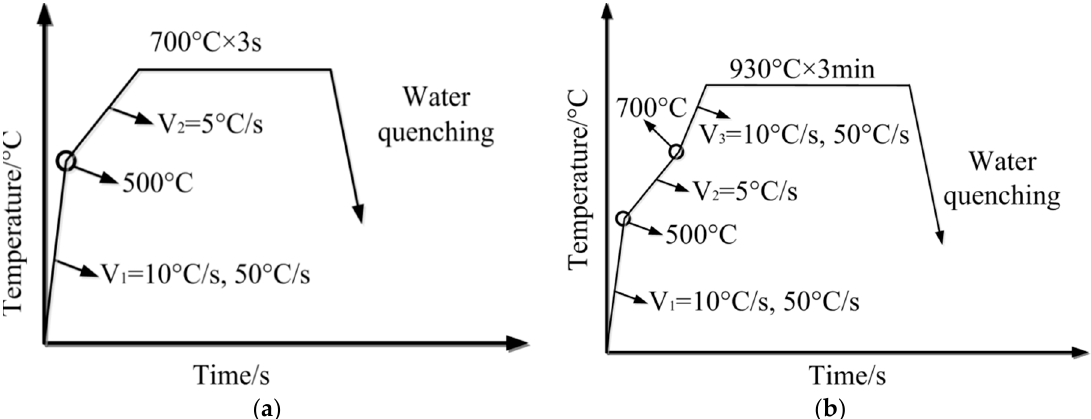
Figure 3. Test schemes of multi-step heating methods of ( a ) two-step heating methods and ( b ) three-step heating methods.